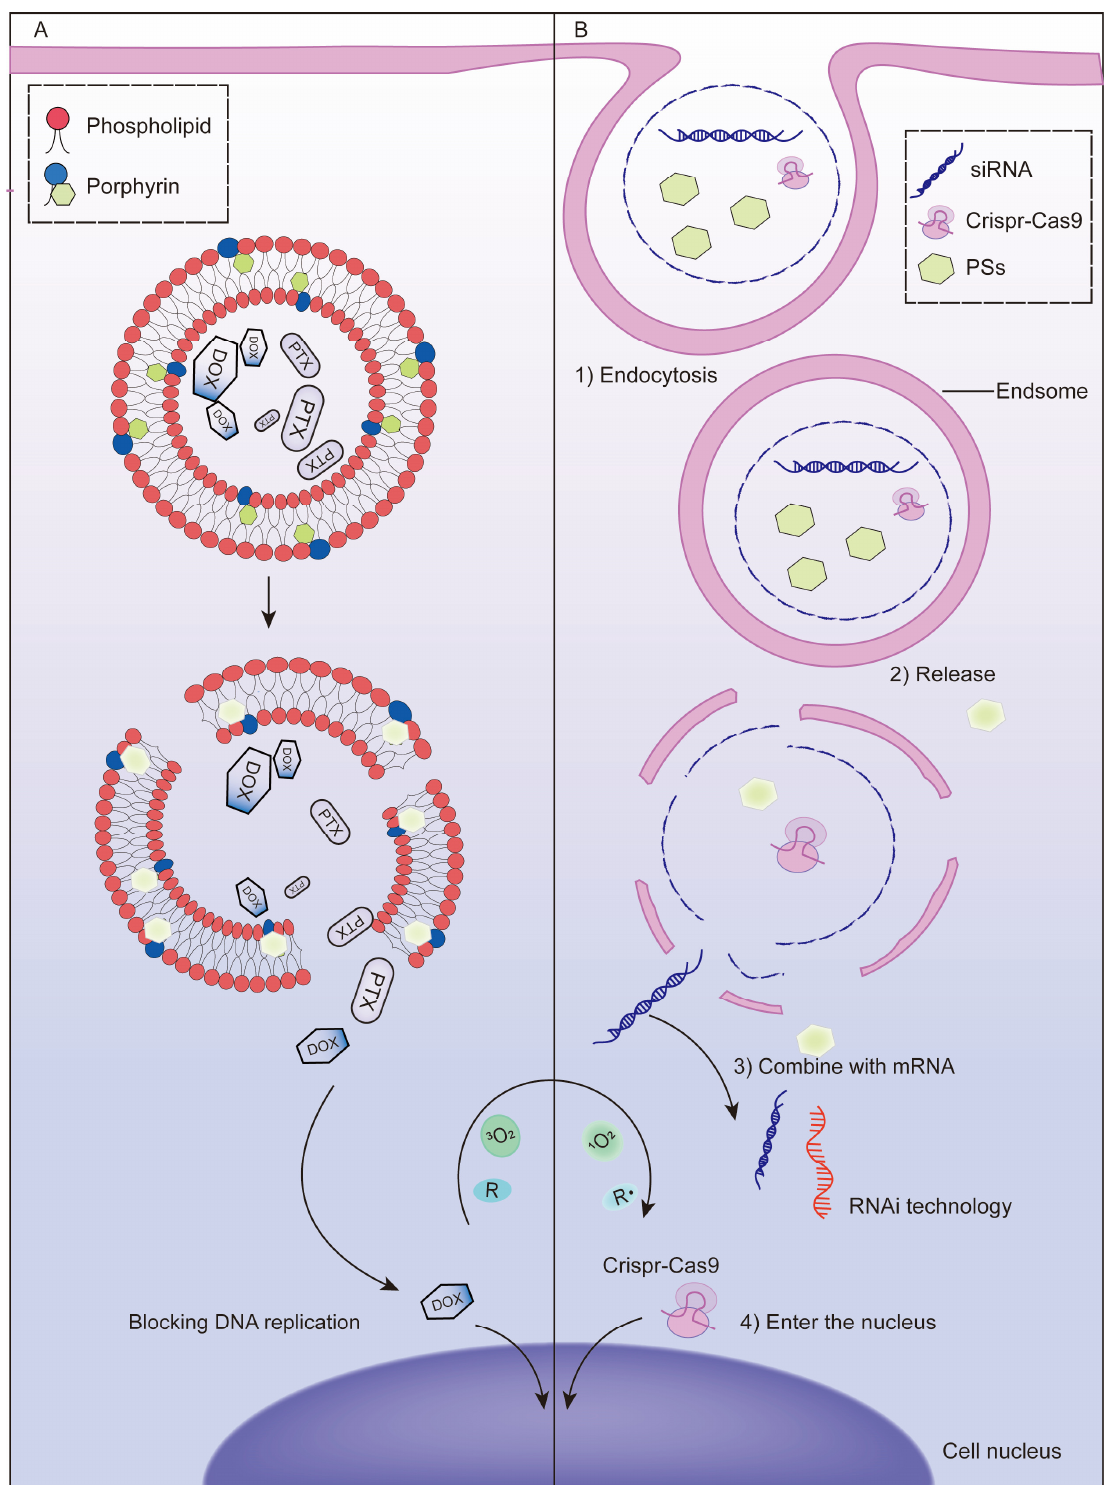
Figure 2. Mechanism of chemotherapy or gene therapy synergistic with PDT to enhance the antitumor effect. ( A ) Diagrammatic illustration of the mechanism of PDT-mediated controlled release of chemotherapy drugs. ROS produced by irradiation can oxidize unsaturated lipids and accelerate the release of chemotherapeutic drugs from porphyrin-phospholipid liposomes. ( B ) Diagrammatic illustration of the mechanism of photochemical internalization (PCI)-mediated endosome escape of nucleic acid drugs. When a photosensitizer is activated by an exogenous light, ROS can be produced rapidly in a short time, destroy the membrane of the intracellular body and release therapeutic genes in the cytoplasm.